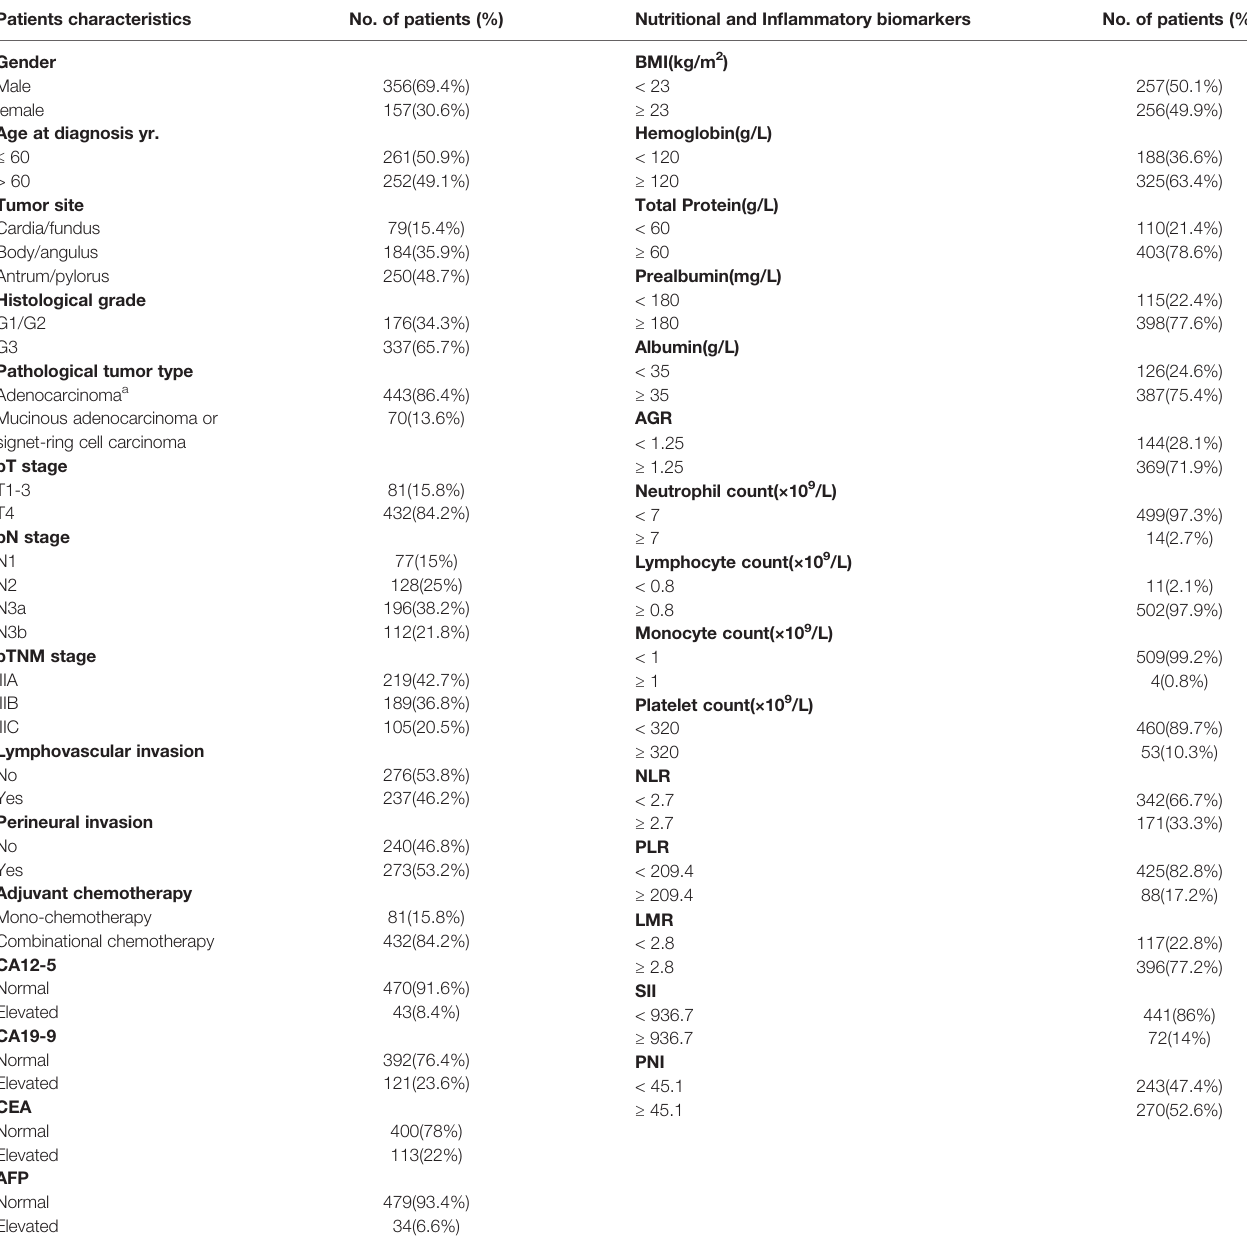
TABLE 1 | The baseline clinicopathological characteristics of 513 GC